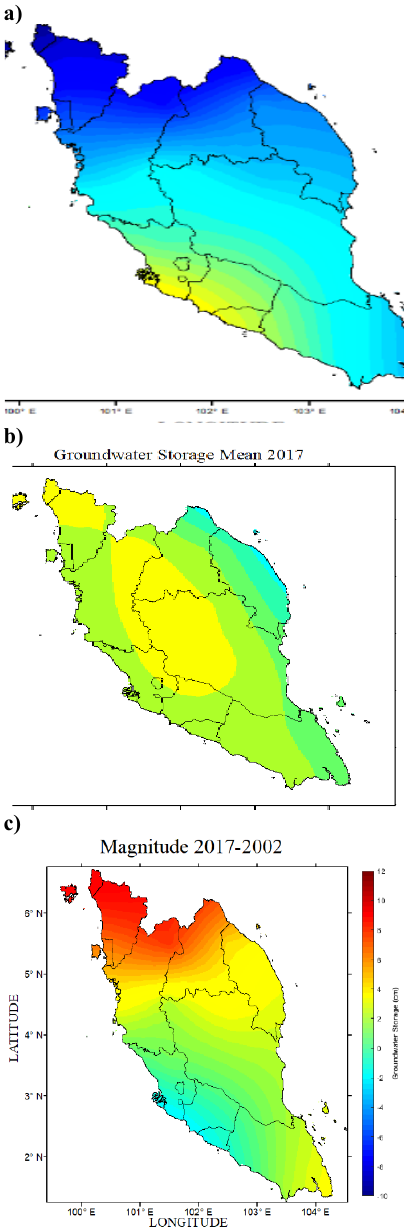
Figure 6. (a) Mean of GWS in 2002, (b) mean of GWS in 2017, and (c) magnitude of GWS from 2017-2002 The rate of GWS changes (mm/year) has been analysed by grid across the Peninsular Malaysia region to identify which part of Peninsular Malaysia has the minimum and maximum recharge value. According to Jalota et al. (2018), the recharge and discharge process of GWS can range from days to thousands of years. As shown in Figure7, the largest storage recharge value (red colour) is in the south region and part of the north region. While the rate indicated by the blue colour is the lowest storage recharge value, located at the centre west of the Peninsular region. This is due to the location of the lowest storage recharge, which is near quarry area, where the activities of quarrying in limestone reservoirs is one of impeding factor of the groundwater flow (Green et al., 2003).